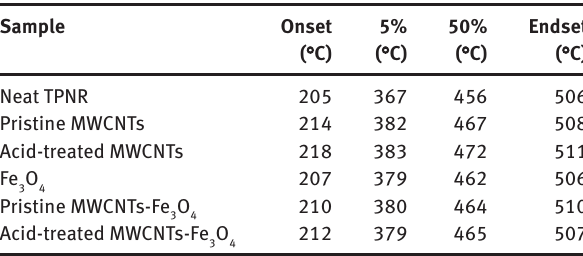
Table 2 Characteristic thermal decomposition temperatures of the neat TPNR and its nanocomposites.